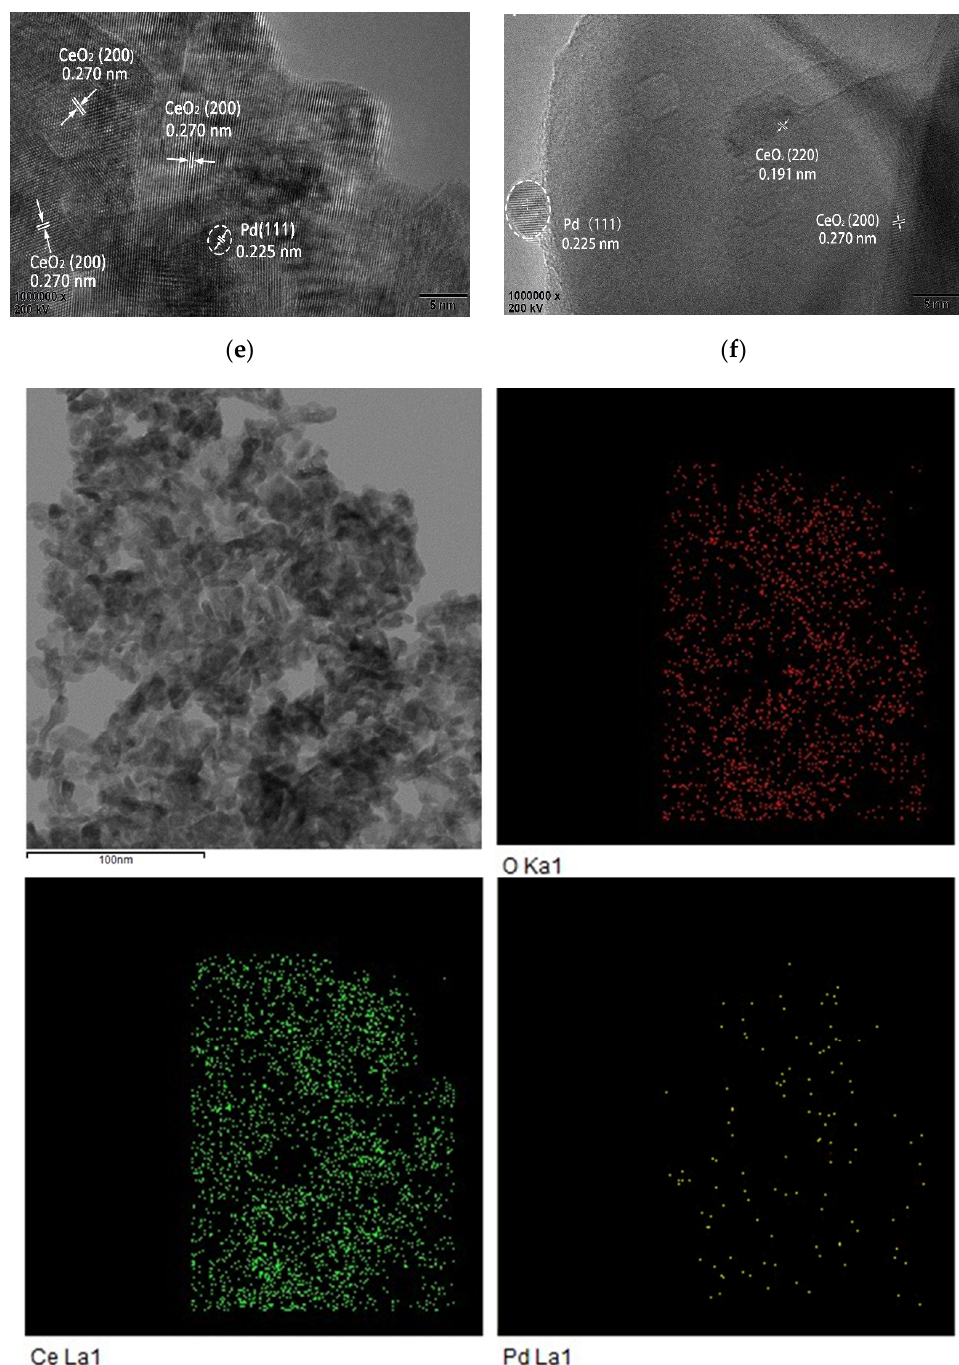
Figure 4. HRTEM images: ( a ) CeO 2 -P; ( b ) CeO 2 -DC; ( c ) CeO 2 -MOF; ( d ) Pd/CeO 2 -P; ( e ) Pd/CeO 2 -DC; ( f ) Pd/CeO 2 -MOF; ( g ) EDS mapping images of Pd/CeO 2 -DC (The red, green and yellow dots represent O, Ce and Pd elements, respectively).